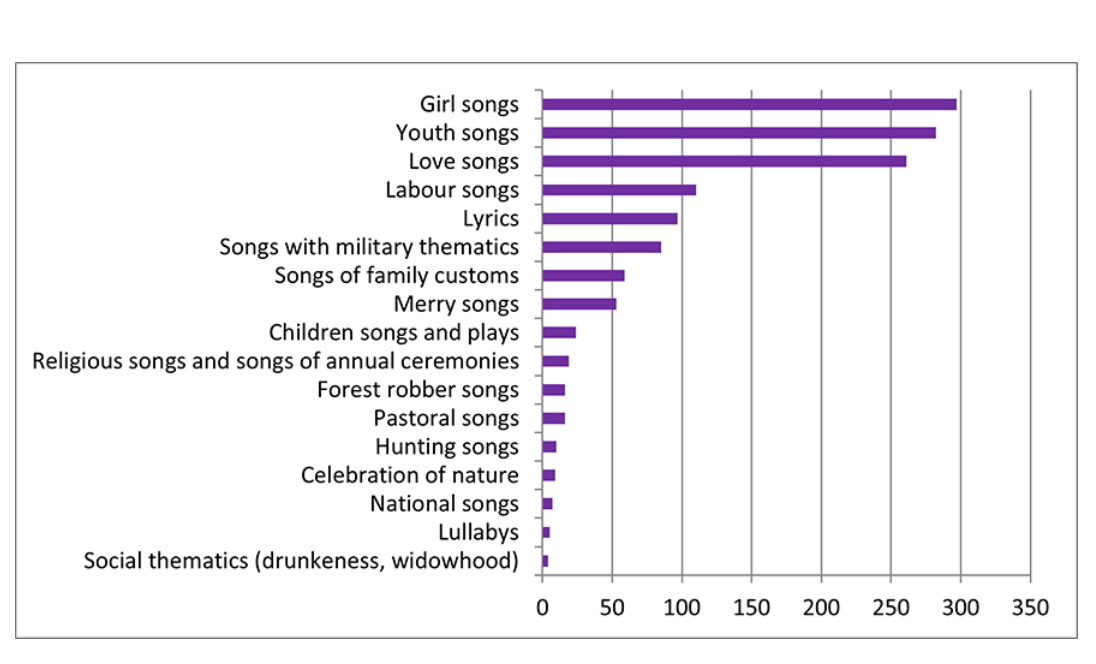
Figure 2 Plant citations according to folk song